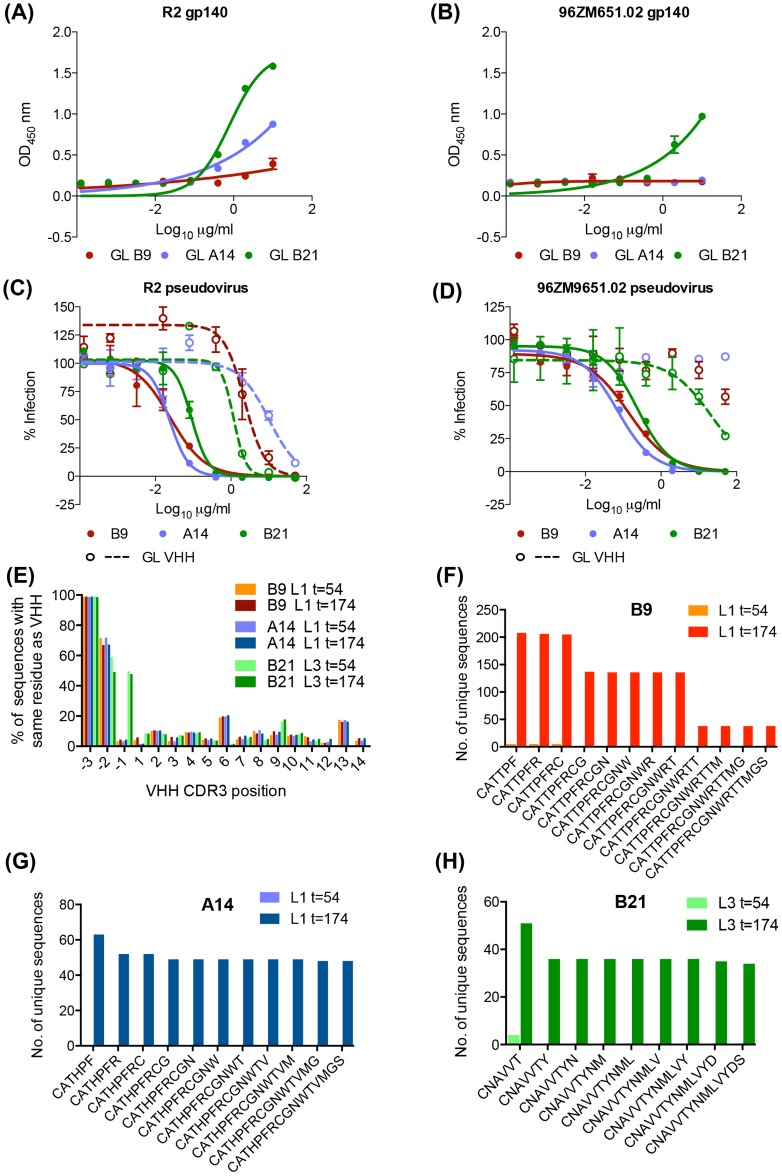
Anti-HIV activity of germ line V gene VHH.GL VHH comprising inferred germ line V gene paired with the mature VHH CDR3 and J region were produced. GL VHH binding to (A) clade B immunogen R2 gp140 and (B) clade C immunogen 96ZM9651.02 gp140 was assessed by ELISA as per the materials and methods. GL VHH neutralization of (C) R2 pseudovirus and (D) 96ZM651.02 pseudovirus was assessed in TZMbl assay as per the materials and methods. (E) Unique sequences from llamas 1 and 3 at both timepoints were filtered for B9, A14 and B21 germ line V gene usage (Vg and Vu) respectively. The y-axis shows the percentage of sequences within each subset with identical residues to each VHH at each individual CDR3 position (and the preceeding three V gene residues −1,−2,−3 = CAT/CNA) indicated on the x-axis. (F, G, H) The number of unique sequences within the subsets which share exact runs of CDR3 residues are plotted on the y-axis against runs of increasing CDR3 length on the x-axis for (F) B9, (G) A14 and (H) B21 at the time points indicated in the legend.